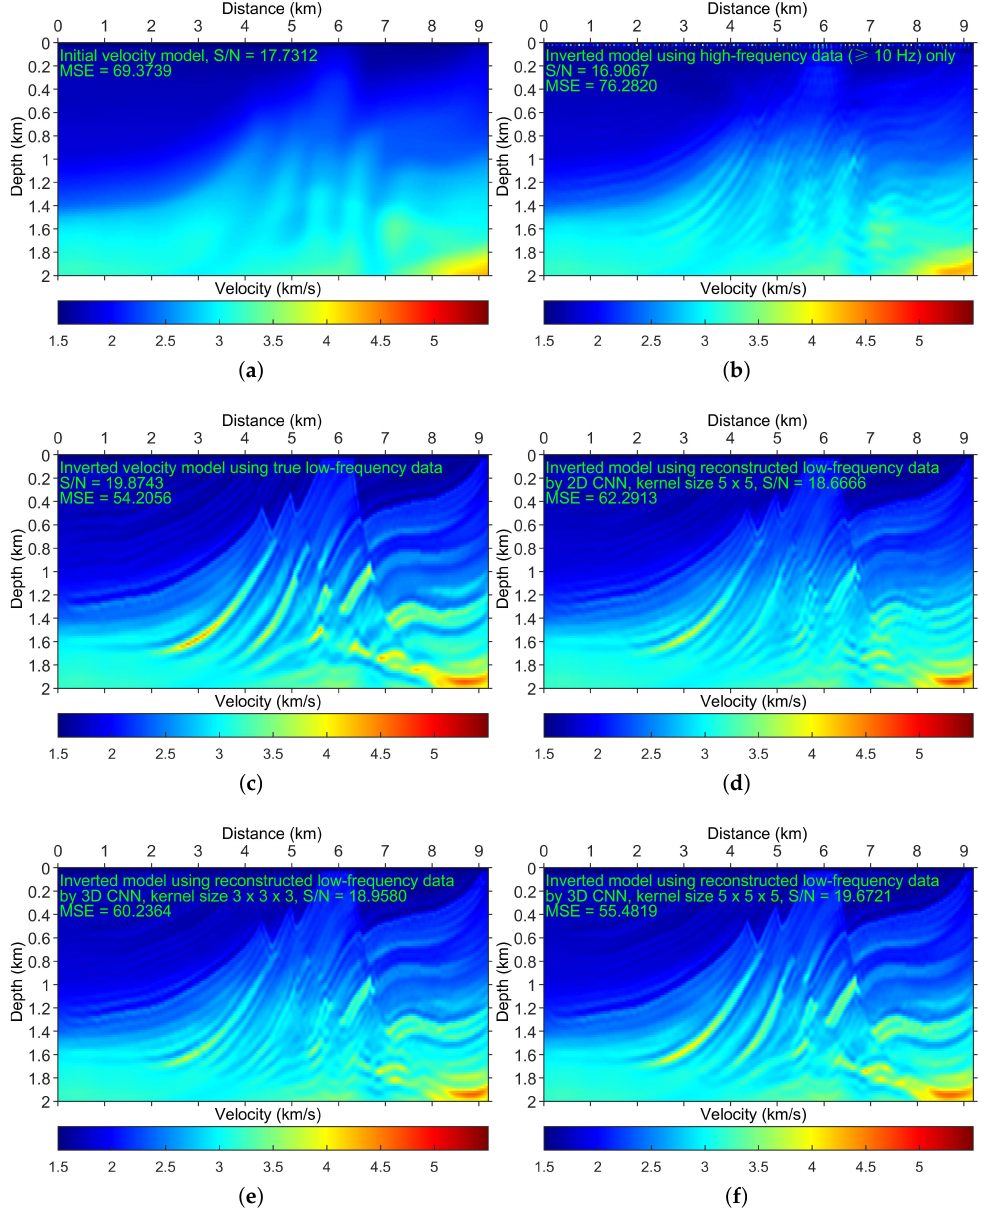
Figure 18. LFR for FWI: Experiments on the Marmousi [39] synthetic dataset generated by PySIT. ( a ) Starting model. ( b ) FWI result for using HF data only. ( c ) FWI result for utilizing the true low frequencies. ( d ) FWI result for using the DL-predicted low-frequencies by 2D CNN, where the kernel size is 5 × 5. ( e ) FWI result for using the DL-predicted low-frequencies by 3D CNN, where the kernel size is 3 × 3 × 3. ( f ) FWI result using the DL-predicted low-frequencies by 3D CNN, where the kernel size is 5 × 5 × 5. For a difference plot highlighting the effectiveness of the reconstruction, please see Figure